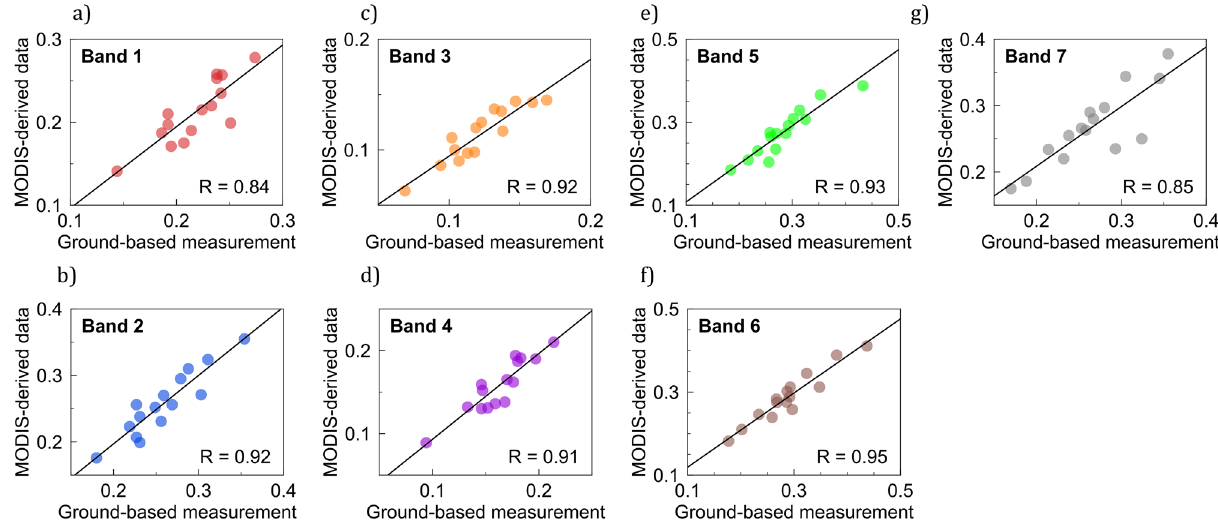
Figure 4. Scatter plots between MODIS-derived estimates of the blue-sky albedo and ground-based measurements of the albedo for the MODIS bands. ( a ) Band 1 (620–670 nm), ( b ) Band 2 (841–876 nm), ( c ) Band 3 (459–479 nm), ( d ) Band 4 (545–565 nm), ( e ) Band 5 (1230–1250 nm), ( f ) Band 6 (1628–1652 nm), and ( g ) Band 7 (2105–2155 nm). Each dot stands for the comparison at a measurement site. Correlation coefficients R are shown in the plots. Plots were generated by using Python’s Matplotlib Library 44